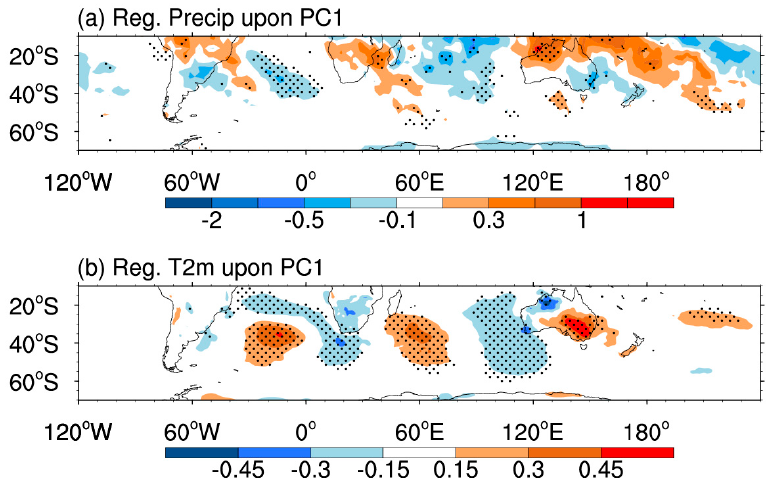
Figure 3. As in Figure 2, but for anomalies of ( a ) precipitation (unit: mm d –1 ) and ( b ) surface air temperature (unit: K) associated with the SAIO pattern, which is obtained through regressing upon the PC1.